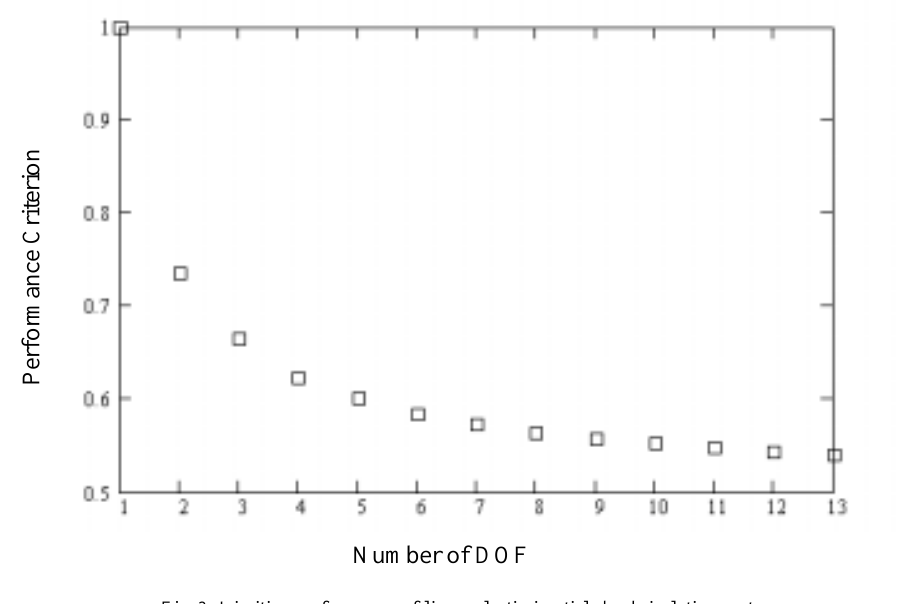
Fig. 3. Limiting performance of linear elastic-inertial shock isolation